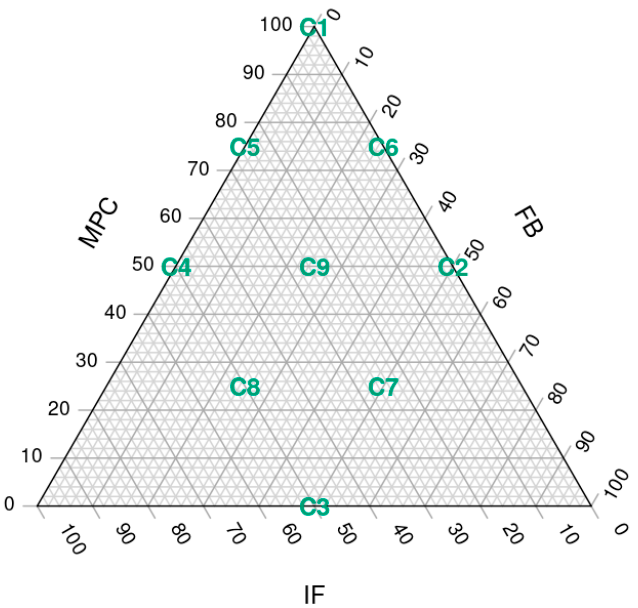
Figure 1. Simplex lattice design plot of ingredient proportions representing 7.1% of spreadable cheese analogue formula, with MPC replacements adding up to 100%. The samples, labelled from C1 to C9, contain different ratios of milk protein concentrate, faba bean protein concentrate and insect flour (MPC/FBP/IF): C1 (100/0/0), C2 (50/50/0), C3 (0/50/50), C4 (50/0/50), C5 (75/0/25), C6 (75/25/0), C7 (25/50/25), C8 (25/25/50) and C9 (50/25/25). The nine different SCA formulations, labelled from C1 to C9 (Figure 2), contained different percentages of MPC, FBP and IF: C1 (7.1, 0, 0), C2 (3.55, 3.55, 0), C3 (0, 3.55,